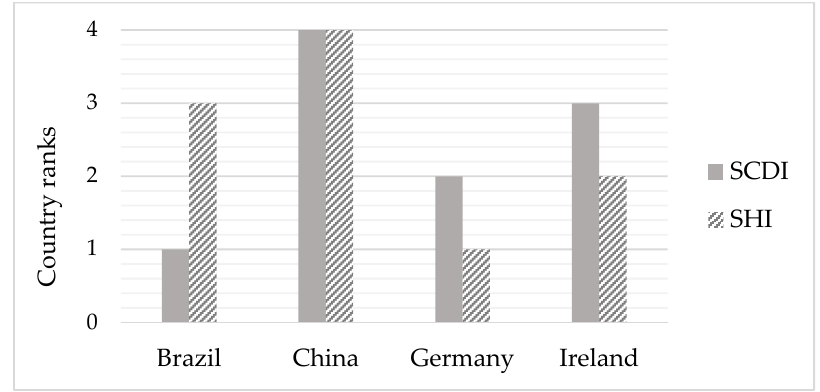
Figure 5. Ranking assessed by the SHI and the SCDI for the four countries involving the bamboo bike supply chain case study (1: Best, 4: Worst).